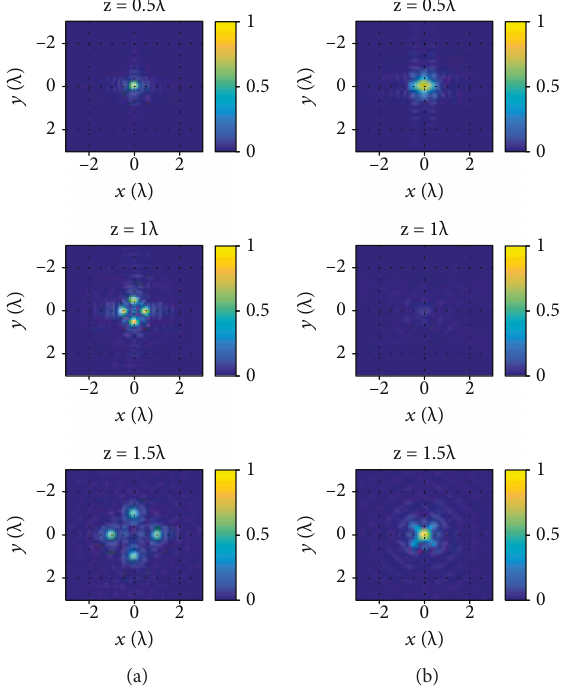
Figure 17: 3D imaging results for the examples shown in Figure 16 for (a) example 1 and (b) example 2. The objects can be clearly observed in the reconstructed images. These results are with SNR =30dB.